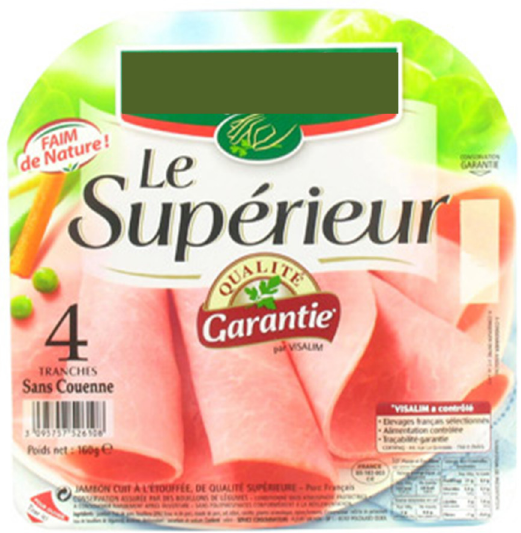
Figure A1. Picture above the multiple price list.